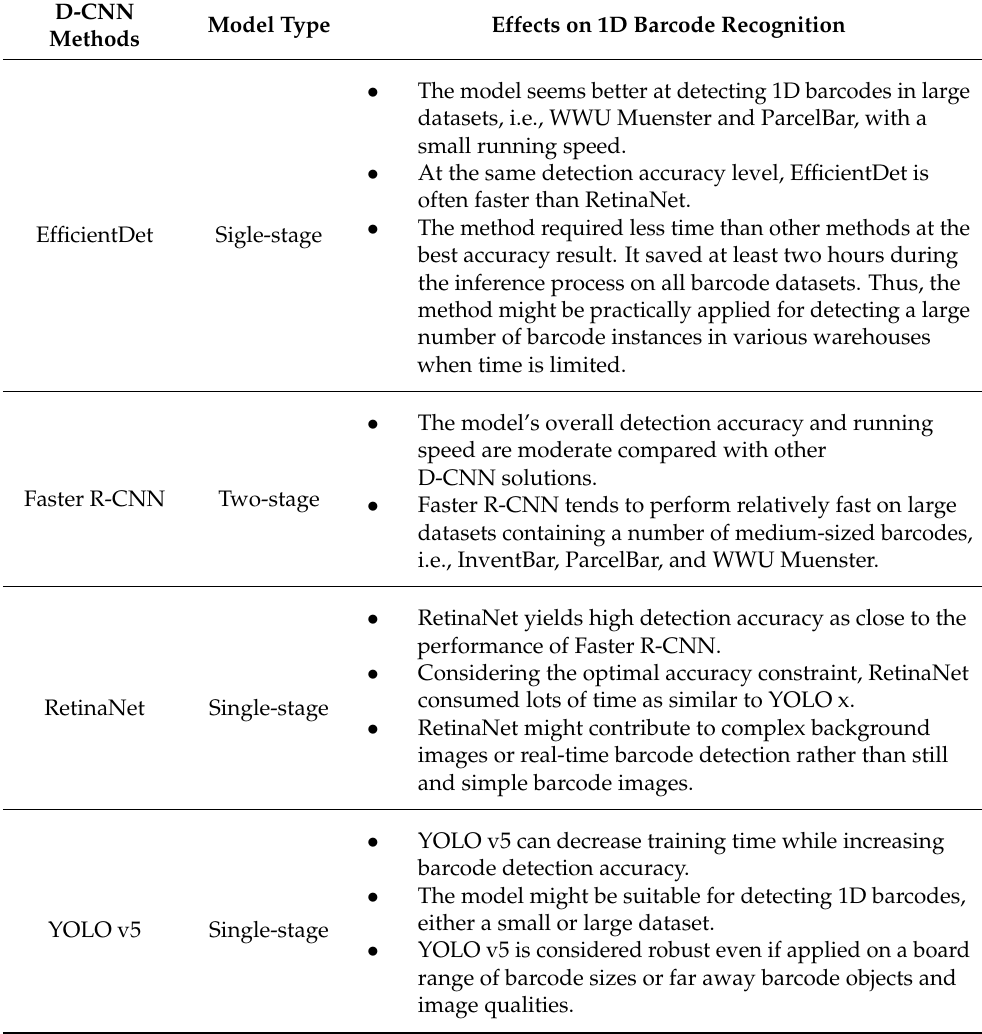
Table 9. Application effects of D-CNN methods on 1D barcode